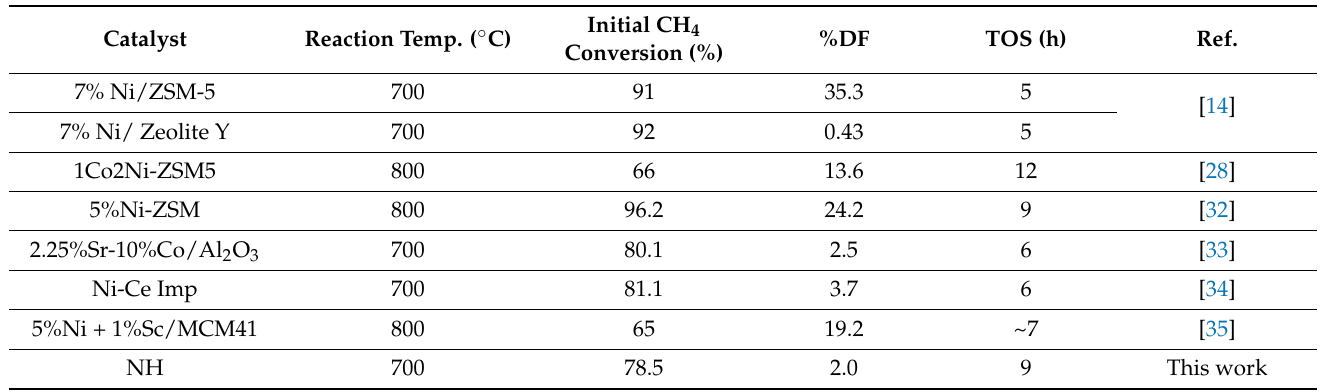
Table 2. Comparison of current work with the previously reported work.